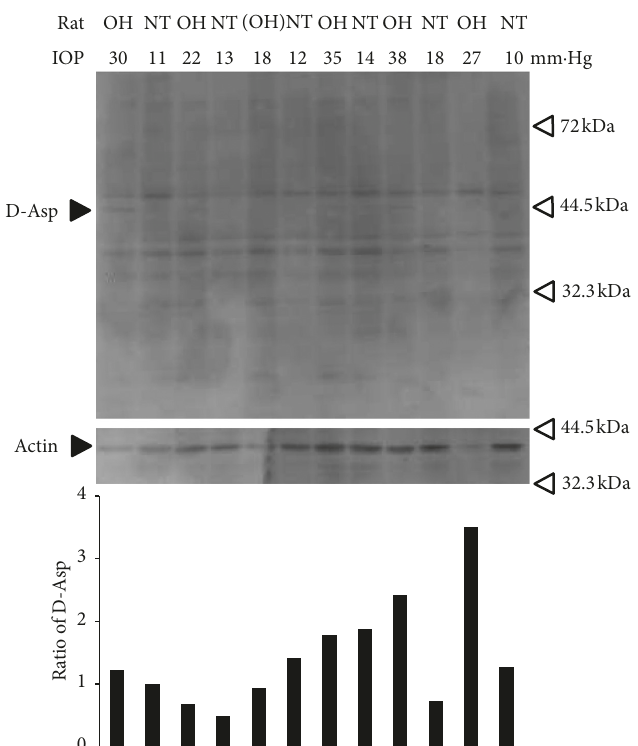
Figure 2: Replicability of the induction of proteins including D-aspartic acid in the retina of ocular hypertensive and normotensive rats. Total lysates of retinas derived from 6 rats with OH or NT eyes blotted with anti-D-aspartic acid antibody and anti-actin antibody. Black arrow, labelled D-Asp, shows the protein band including D-aspartic acids. The samples of the first and second lanes are the same as in Figure 1(a) and are blotted as a positive control. The fifth and sixth lanes were derived from a rat which failed to achieve glaucoma status (defined as IOP > 21) and was blotted as a negative control. Lowest panel, which shows the ratios of the expression volumes of proteins containing D-aspartic acid corrected with each actin expression, showed that protein bands in the first, third, ninth, and eleventh lane had a stronger protein band including D-aspartic acid around 44.5kDa than control NT.